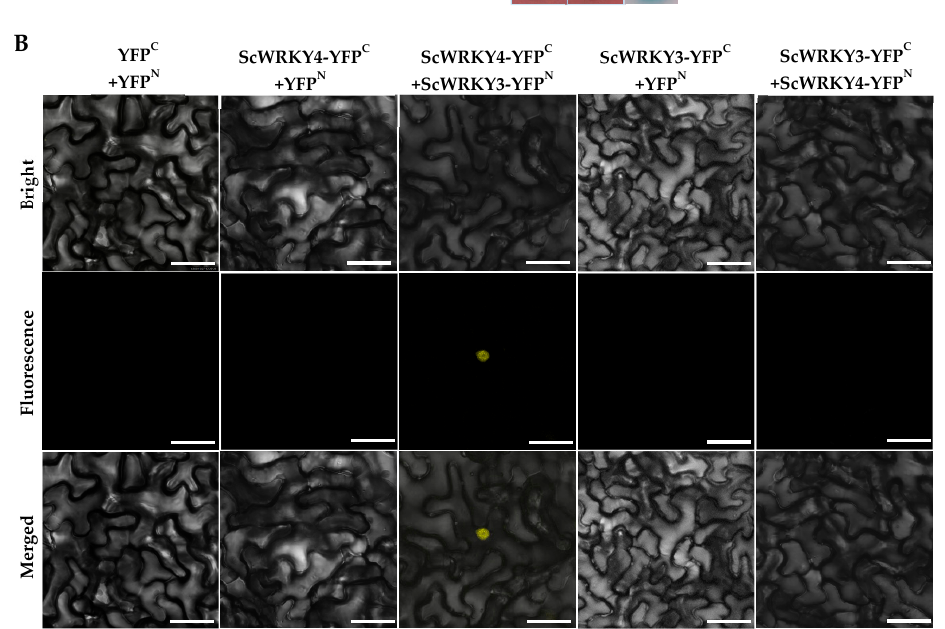
Figure 6. Interaction between ScWRKY3 and ScWRKY4 in yeast and in Nicotiana benthamiana leaves. (A) The interaction between ScWRKY3 and ScWRKY4 was verified using a yeast two-hybrid system. A variety of BD and AD vectors were combined and transformed into GoldY2H yeast. Left to Right: Transformations were grown and screened on DDO (SD/-Leu/-Trp, SD medium without leucine and tryptophan), QDO (SD/-Ade/-His/-Leu/-Trp, SD medium without adenine, histidine, leucine, or tryptophan), and QDO/X/A (SD/-Ade/-His/-Leu/-Trp/X- α -Gal/AbA, QDO medium with X- α -D- Galactosidase and aureobasidin medium. (B) The bimolecular fluorescence complementation (BiFC) 50 μ m. YFP C , YFP N , ScWRKY4-YFP C , ScWRKY4-YFP N , ScWRKY3-YFP C , and ScWRKY3-YFP N SPYCE, ScWRKY4-pUC-SPYNE, ScWRKY3-pUC-SPYCE and ScWRKY3-pUC-SPYNE, respectively.